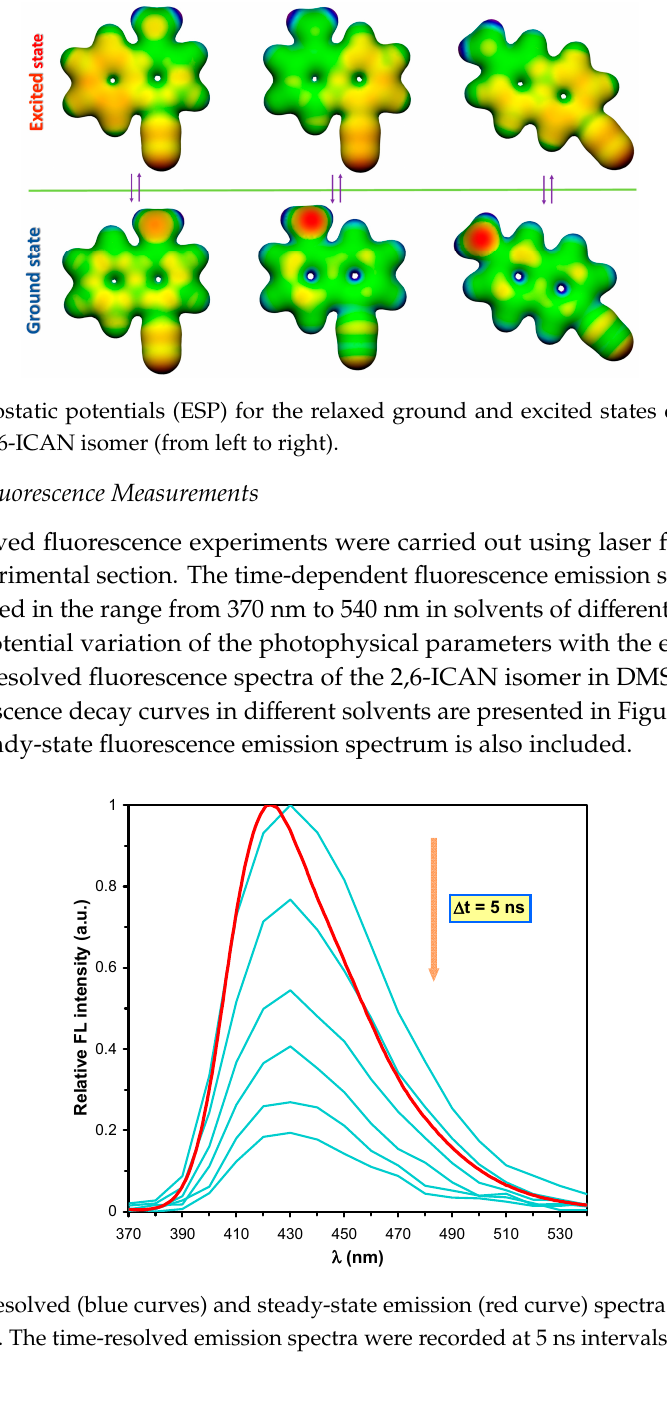
Figure 6. Time-resolved (blue curves) and steady-state emission (red curve) spectra of the 2,6-ICAN isomer in DMSO. The time-resolved emission spectra were recorded at 5 ns intervals.